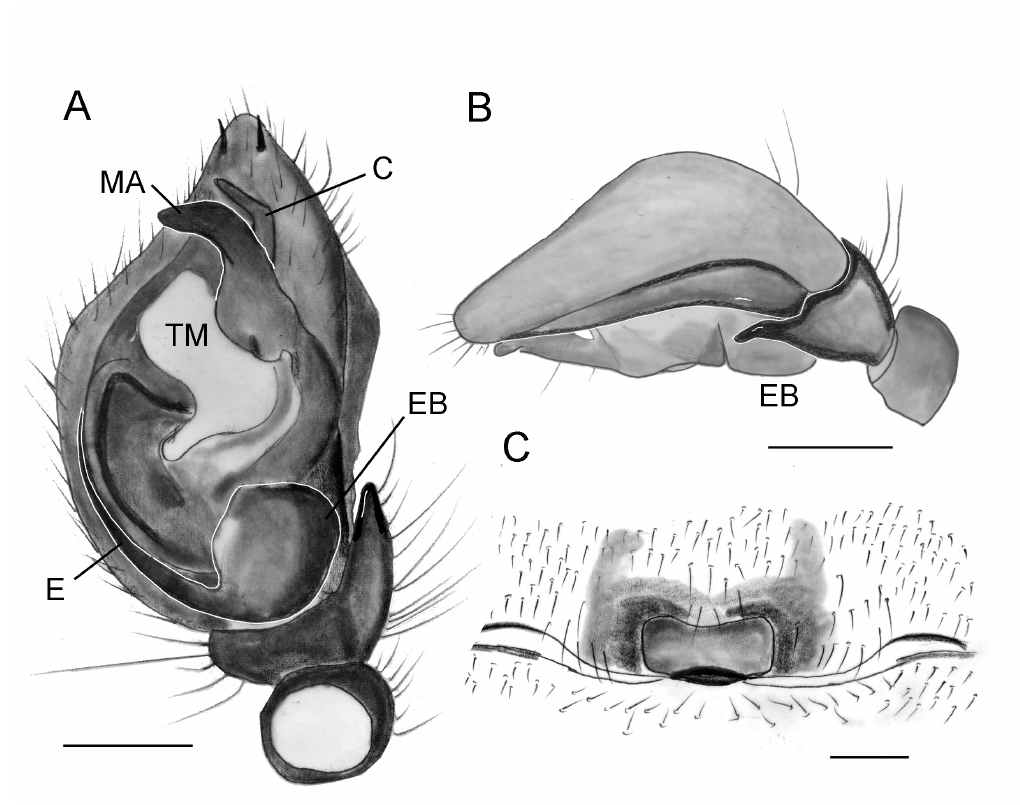
Fig. 7. Cambonilla securicula Jocqué gen. et sp. nov. A–B . Male holotype. C . Female paratype (RBINS IG 33.889/003). A . Male palp, ventral view. B . As preceding, retrolateral view. C . Epigyne, ventral view. Abbreviations: C = conductor; E = embolus; EB = embolus base; MA = median apophysis; TM = tegular membranous area. Scale bars: A–B = 0.5 mm; C = 0.2